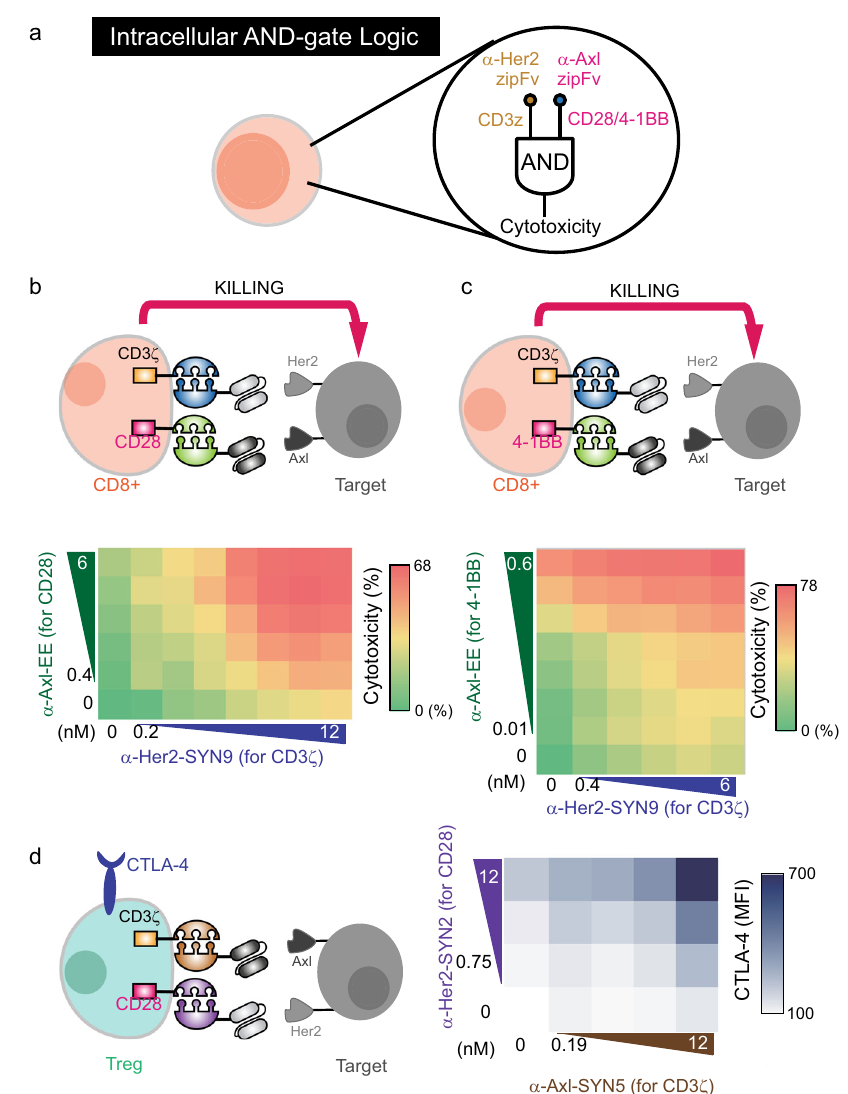
Fig. 3 The intracellular AND logic with different signaling domains. a Diagram of intracellular AND logic. b Primary human CD8 + T cells were transduced with FOS zipCAR-containing CD3 ζ domain and RR zipCAR-containing CD28 domain. Cytotoxicity against Her2- and Axl-expressing Nalm6 was measured 24 h after adding α -Her2-SYN9 and/or α -Axl-EE zipFvs. The heatmap indicates cytotoxicity at varying zipFv concentrations ( n = 3, data are represented as mean). c Cytotoxicity of CD8 + T cells transduced with FOS zipCAR-containing CD3 ζ domain and RR zipCAR-containing 4-1BB domain. The heatmap indicates cytotoxicity at varying zipFv concentrations ( n = 3, data are represented as mean). d (Left) Isolated Treg cells were transduced with two zipCAR constructs: SYN6-CD3 ζ -P2A-FOXP3 and SYN1-CD28-P2A-puro. After puromycin selection (2 μ g/mL), Treg cells were co-cultured with Her2- and Axl-expressing Nalm6 target cells (Right) The heatmap shows surface CTLA-4 expression detected after 48 h by fl ow cytometry at varying zipFv concentrations ( α -Axl-SYN5 and α -Her2-SYN2) ( n = 3, data are represented as